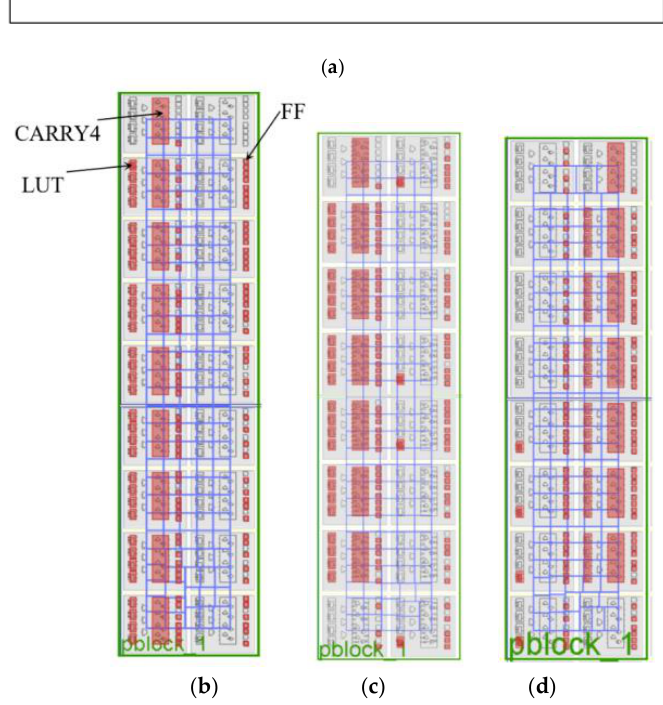
Figure 4. Some layouts of 32-bit adders: ( a ) constraints used; ( b ) FP; ( c ) New; ( d ) AA6 [16].